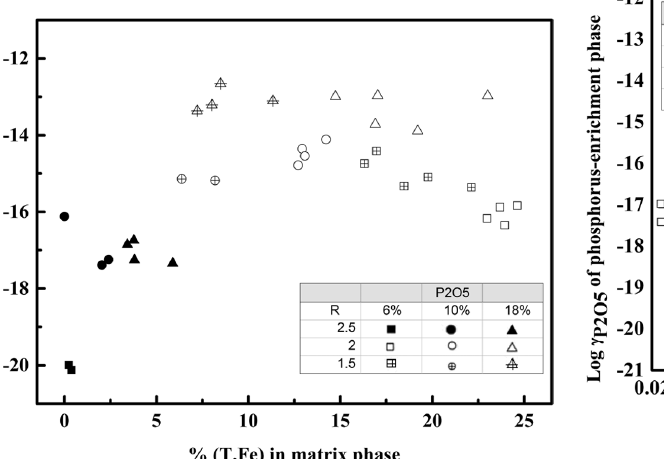
Fig. 12: The effect that P 2 O 5 content of phosphorus-enrichment phase on the activity coefficient of P 2 O 5 of the CaO-SiO 2 -Fe t O-P 2 O 5 slag